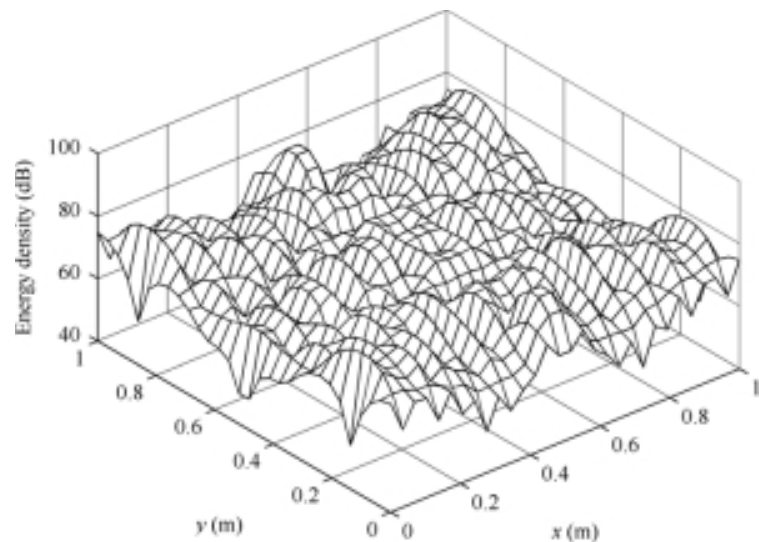
Fig. 3. The classical energy density distribution of the orthotropic plate when f = 500 Hz and η = 0 . 02 . The reference energy density is 1 × 10 − 12 J/m 2 .